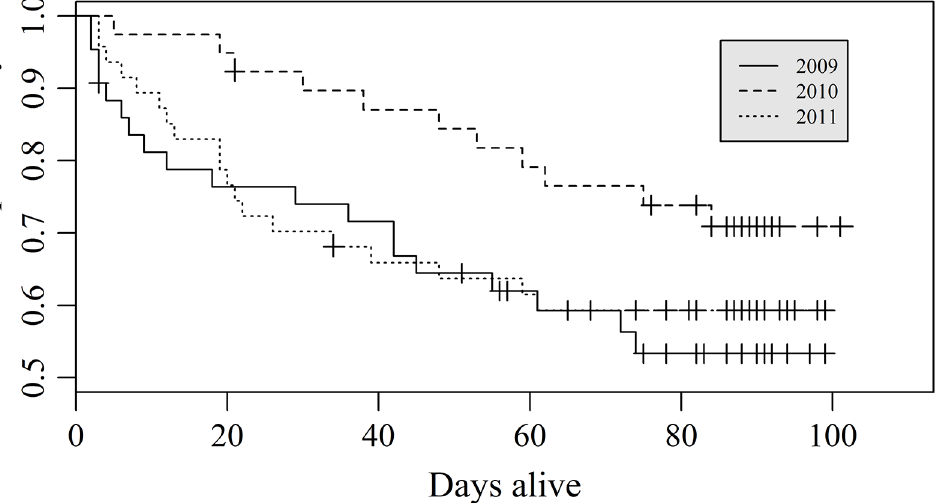
Fig 1. Kaplan – Meier estimates of neonate white-tailed deer fawn ( (cid:1) 14 weeks of age; Odocoileus virginianus ; n = 129) survival from 14 May – 31 August 2009 – 2011 in the southcentral Upper Peninsula of Michigan,